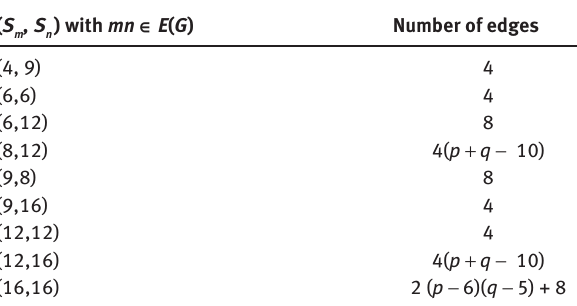
Table 2: The cardinality of edges of type ( S and n are sum of degrees of all neighboring vertices of end vertices of each